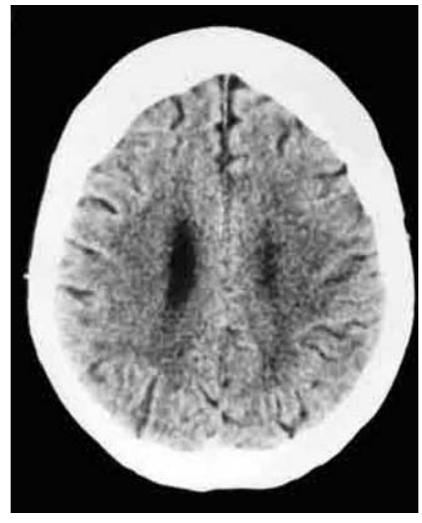
Computerised tomography scan of the brain on the day of admission showing bilateral chronic subdural